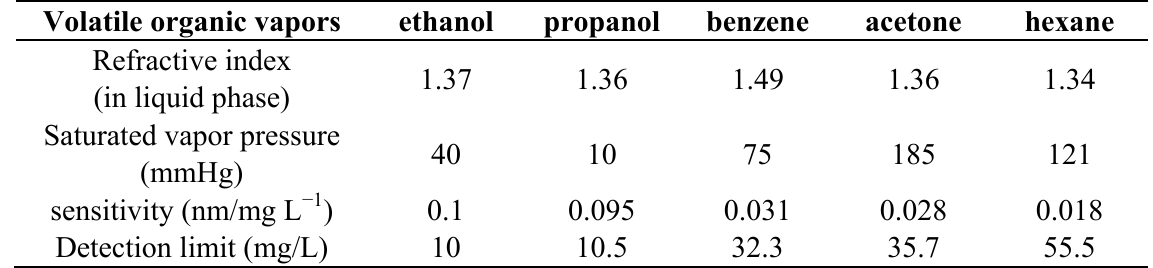
Table 1. Comparison of the physical characteristics and LSPR selectivity of the five test